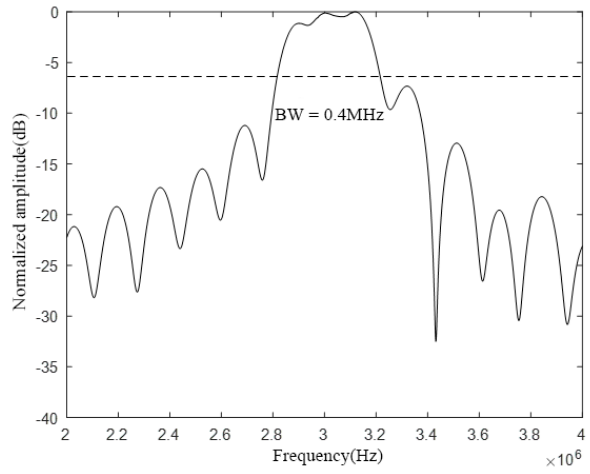
Figure 8. A CMUT bandwidth consisting of three cell sizes.